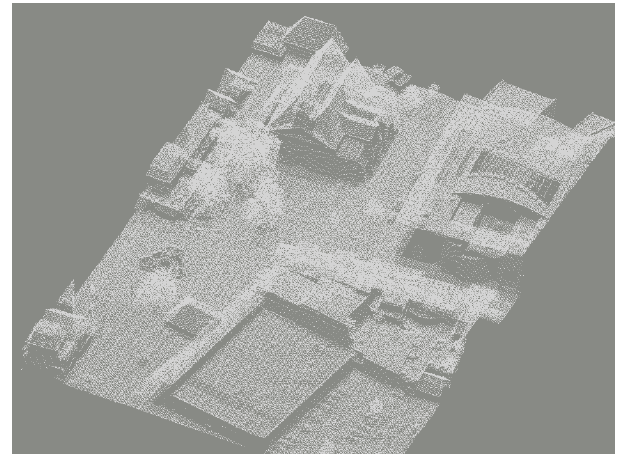
Figure 1. Screenshot subset